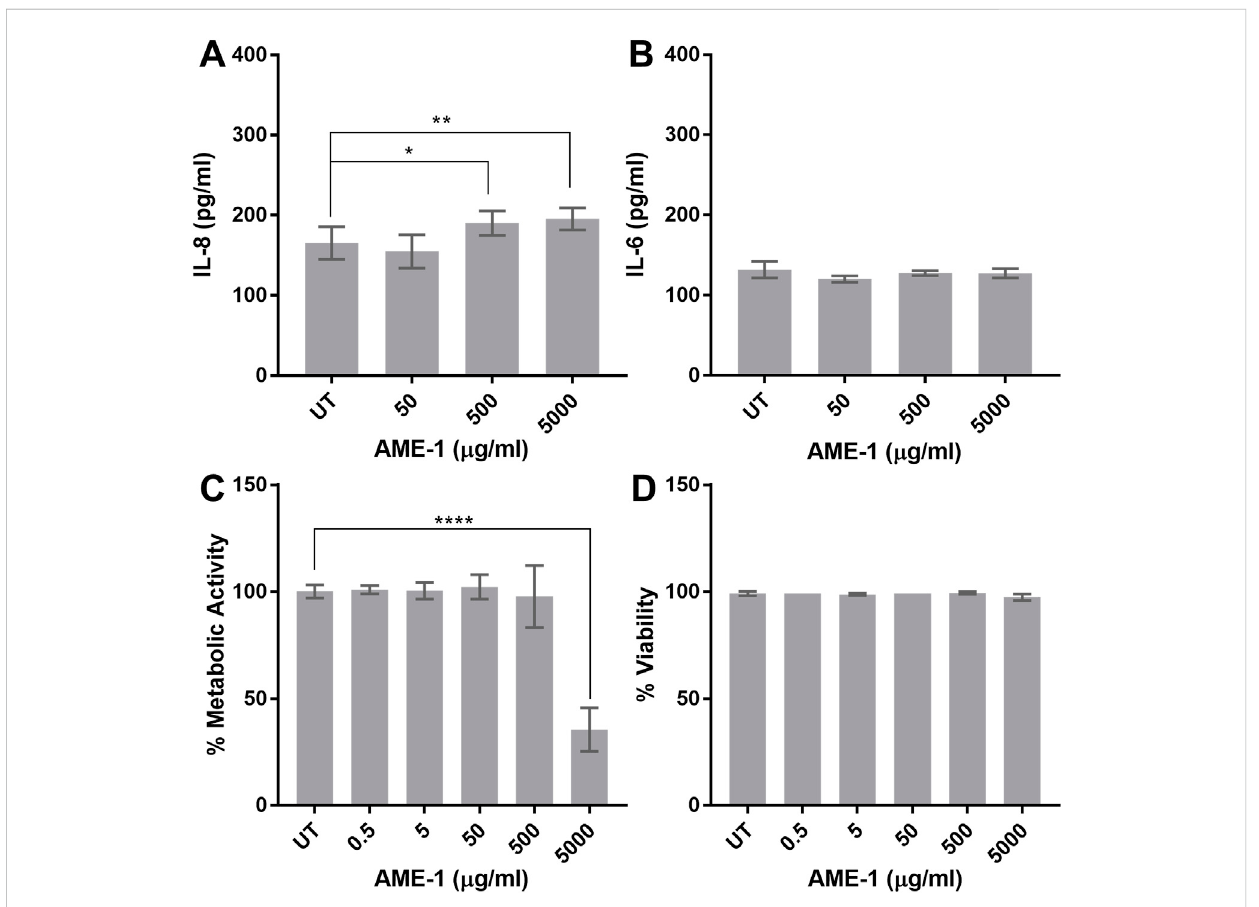
FIGURE 4 AME-1 effect on IL-8 and IL-6 production and metabolic activity. (A, B) HMC3 were treated with AME-1 (50 – 5,000 µg/mL) or left untreated (UT) for 24 h and IL-8 and IL-6 production was measured by ELISA. HMC3 were treated as in (A) and metabolic activity and viability was analyzed via (C) XTT and (D) trypan blue exclusion assay. Data presented as mean ± SEM for n = 3. Statistical signi fi cance was calculated using one-way ANOVA with Dunnett ’ s multiple comparison pot-hoc analysis relative to untreated (UT): p ≤ 0.05 (*), p ≤ 0.01 (**), p ≤ 0.0001